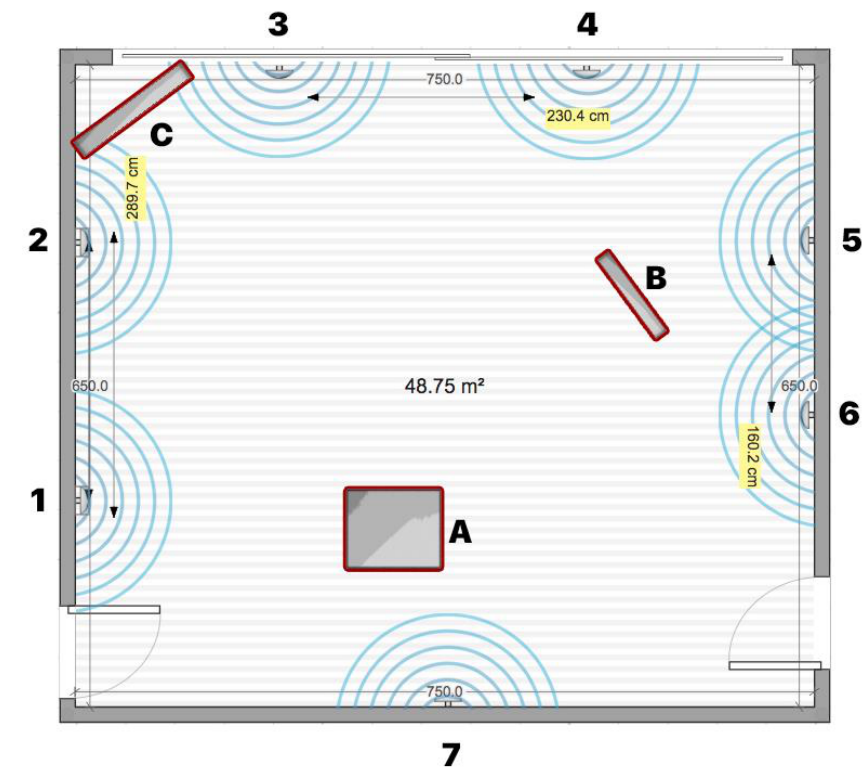
Figure 7. Testing environment with medium obstacle Figure 6. Testing environment with medium obstacle severity.